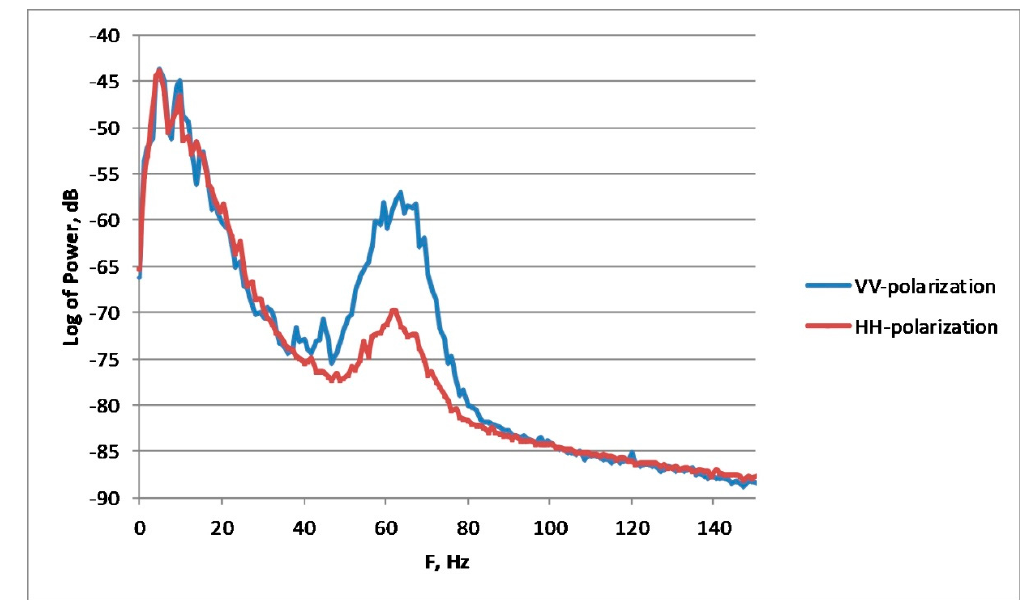
Figure 3. An example of the radar Doppler spectrum at VV- and HH-polarizations. Wind velocity of 1.1